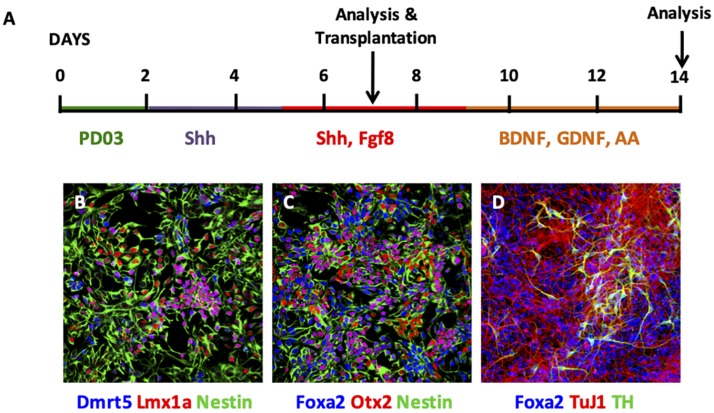
Characterisation of EpiSC monolayer differentiation. (A) Schematic of monolayer differentiation protocol. (B–D) Photomicrographs of immunofluorescent cytochemistry of cells at day 7 (B,C) and day 14 (D). At day 7, EpiSCs expressed Dmrt5 (blue), Lmx1a (red), and Nestin (green) (B); and Foxa2 (blue), Otx2 (red), and Nestin (green) (C). At day 14, EpiSCs expressed Foxa2 (blue), TuJ1 (red), and TH (green) (D). PD03, PD0325901; Shh, Sonic hedgehog; AA, ascorbic acid.